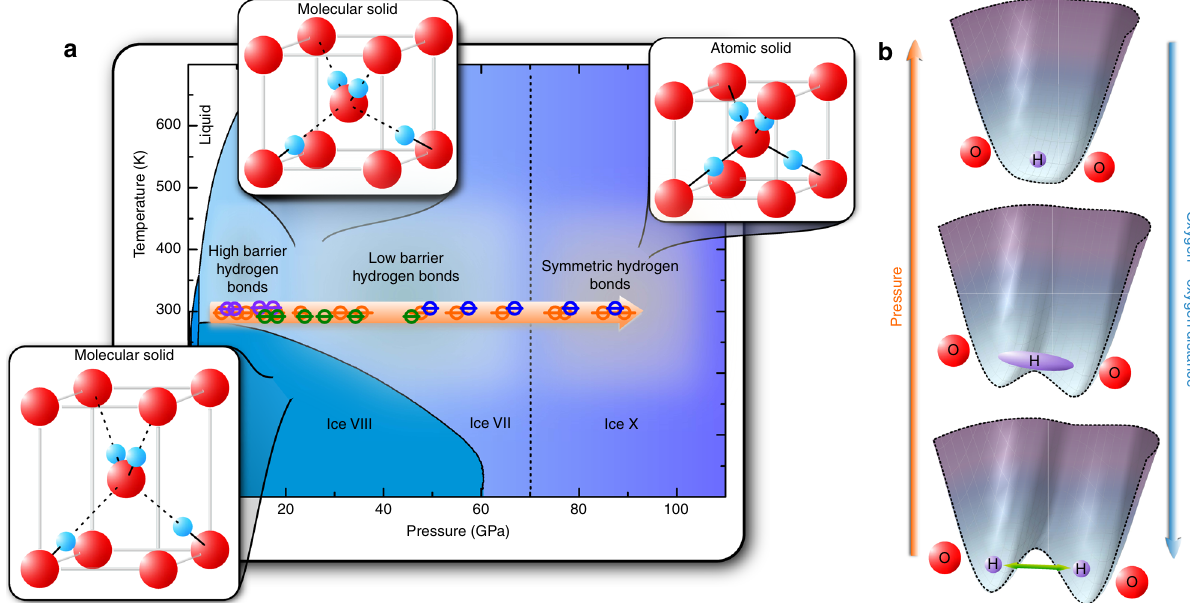
Fig. 1 Phase diagram of H 2 O and schematic representation of hydrogen bond symmetrisation. a Phase diagram of H 2 O. The insets show the schematic symmetries of the high-pressure phases of ice VII, VIII, and X. Round symbols denote NMR measurements within this study, different colors relate different separate high pressure NMR experiments. b Sequence of hydrogen bond symmetrisation with